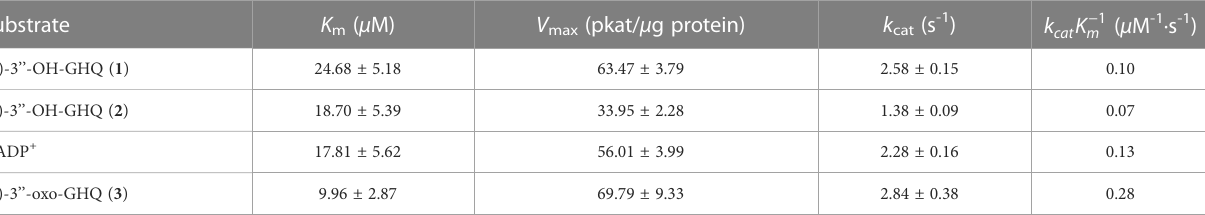
TABLE 1 Kinetic parameters of AeHGO.